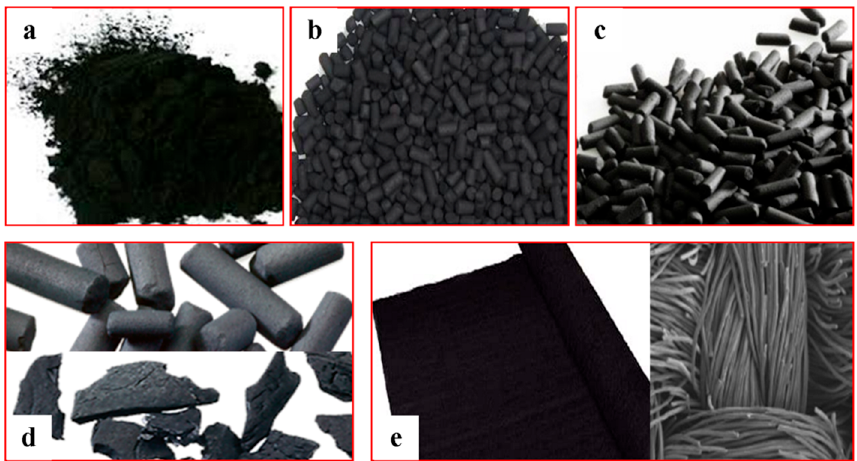
Figure 4. Forms of activated carbon: ( a ) activated carbon powder, ( b ) granular activated carbon, ( c ) extruded activated carbon, ( d ) impregnated activated carbon, ( e ) activated carbon fabric.